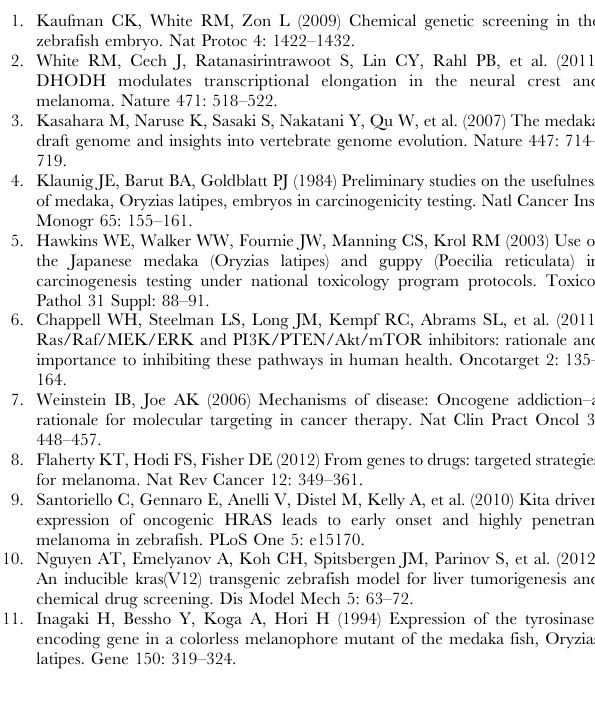
Figure S2 Effect of sorafenib ( 0.3 m M ) treatment on melanophore hyperplasia and overall survival in Tg ( tyr:HRAS G12V ) / Tg ( hsp:cre ) medaka. ( A ) Schedule of drug administration. ( B ) Photos taken from the dorsal side of all fish